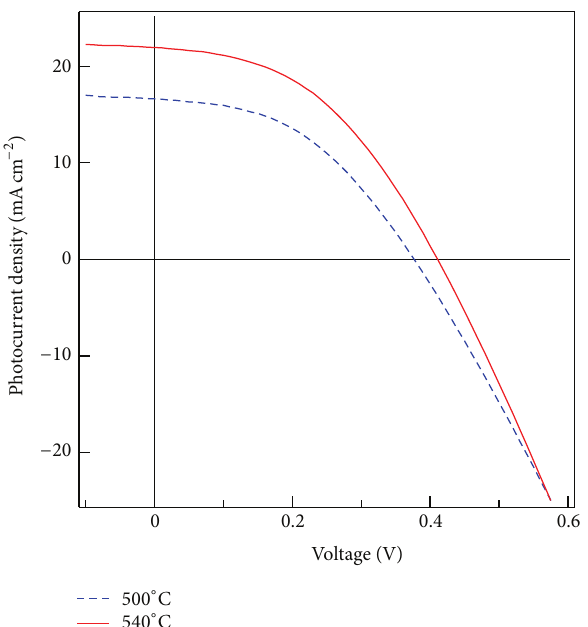
Figure 4: Photocurrent density-voltage curves of CIGS solar cells annealing at 500 and 540 ∘ C for 30min under a selenium vapor ambience.